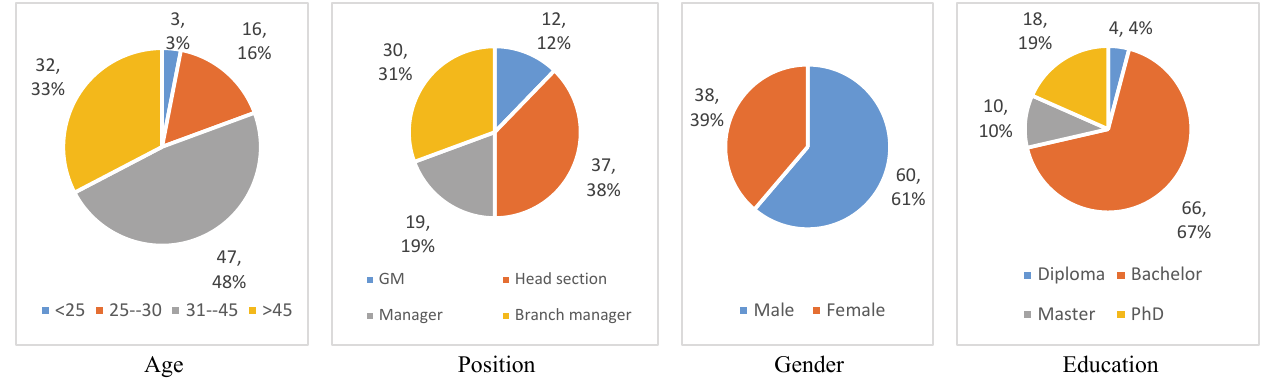
Fig. 2. Personal characteristics of the